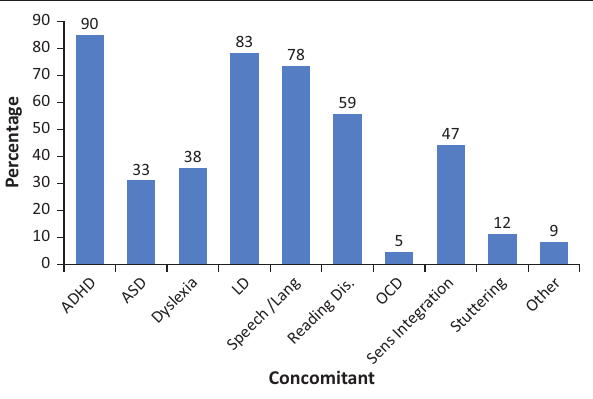
FIGURE 1: Common concomitant childhood disorders associated with auditory processing